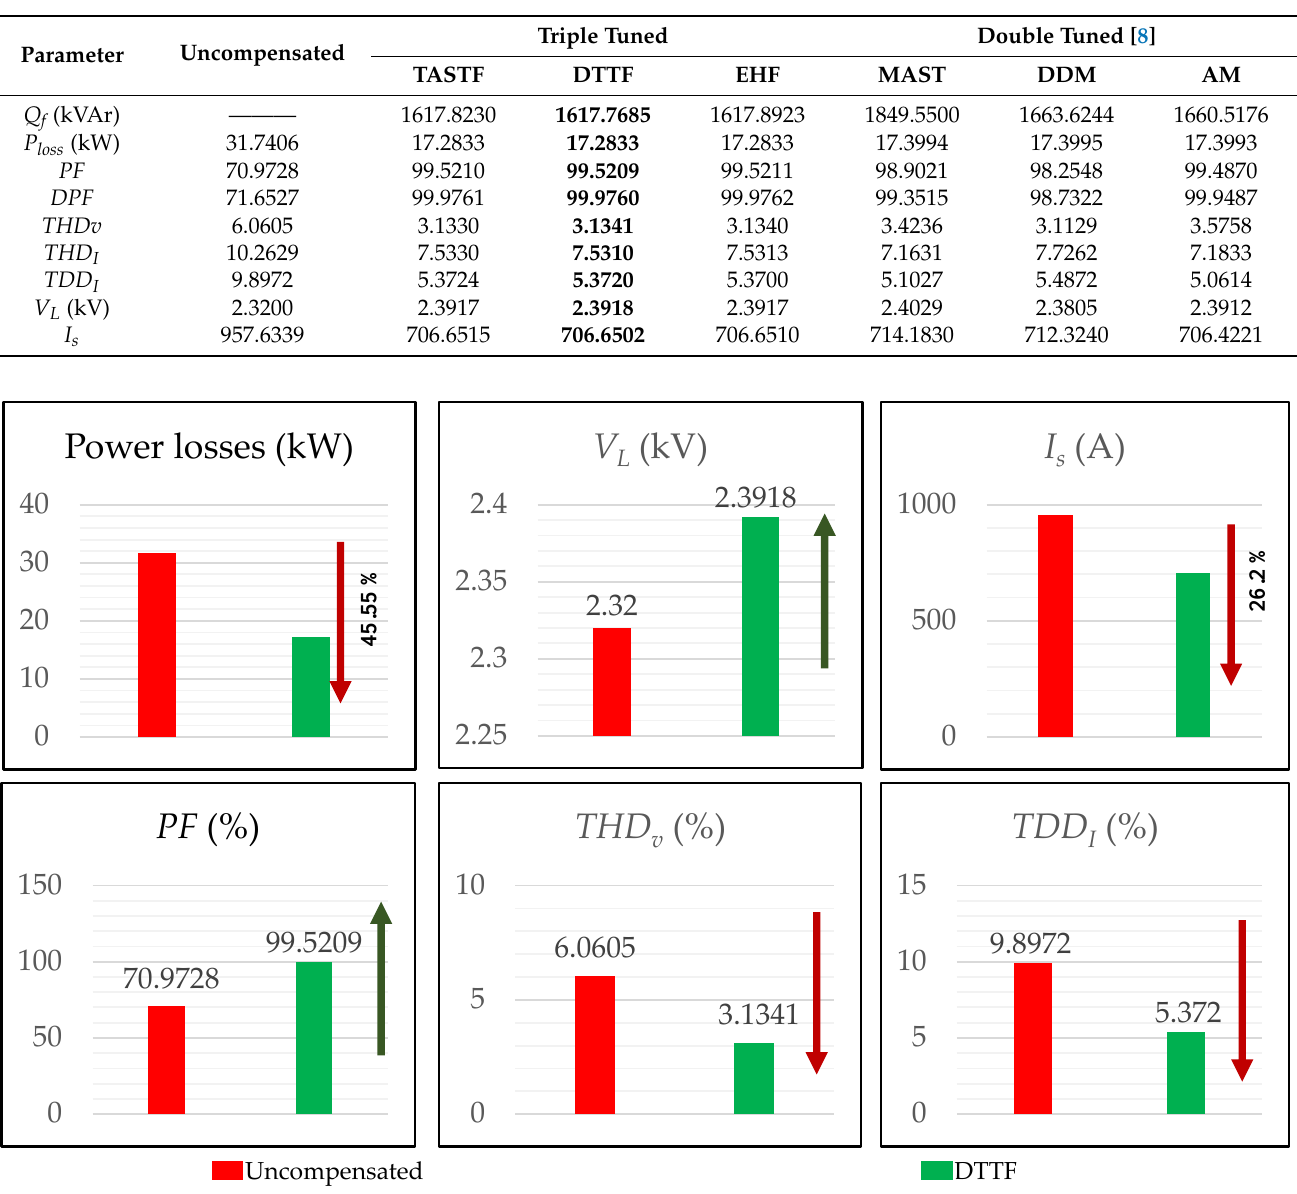
Table 5. Compensated system results compared to the original system and the results in [8].